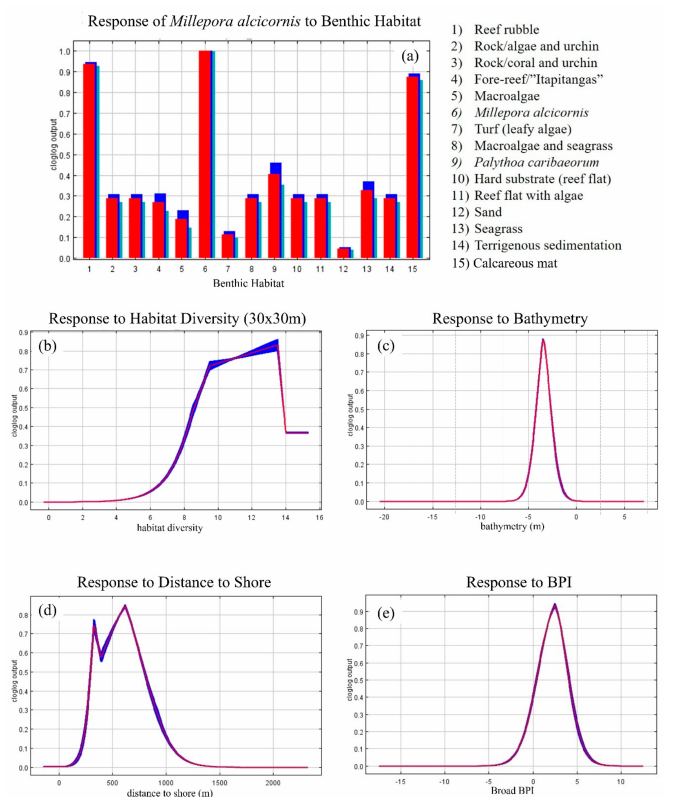
Figure 11. Response curves for the most influential variables of the model: ( a ) benthic cover, ( b ) habitat diversity, ( c ) bathymetry, ( d ) distance to shore and ( e ) broad-scale bathymetric position index (BPI). The curves show the mean response of the 15 replicate MaxEnt runs (red) and the mean +/ − one standard deviation (blue, two shades for the categorical